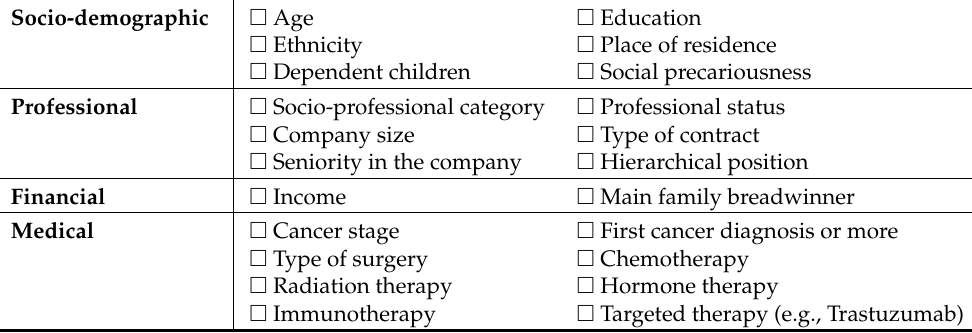
Table 2. Reminder of the variables to be recorded in the medical